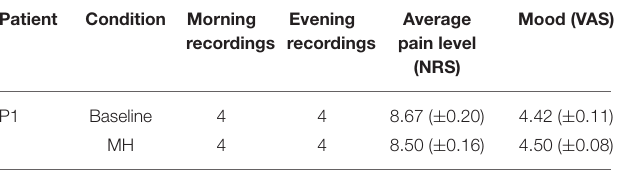
TABLE 2 | Matched sham stimulation recordings in the baseline (pre-MH onset) and MH (post-MH onset)